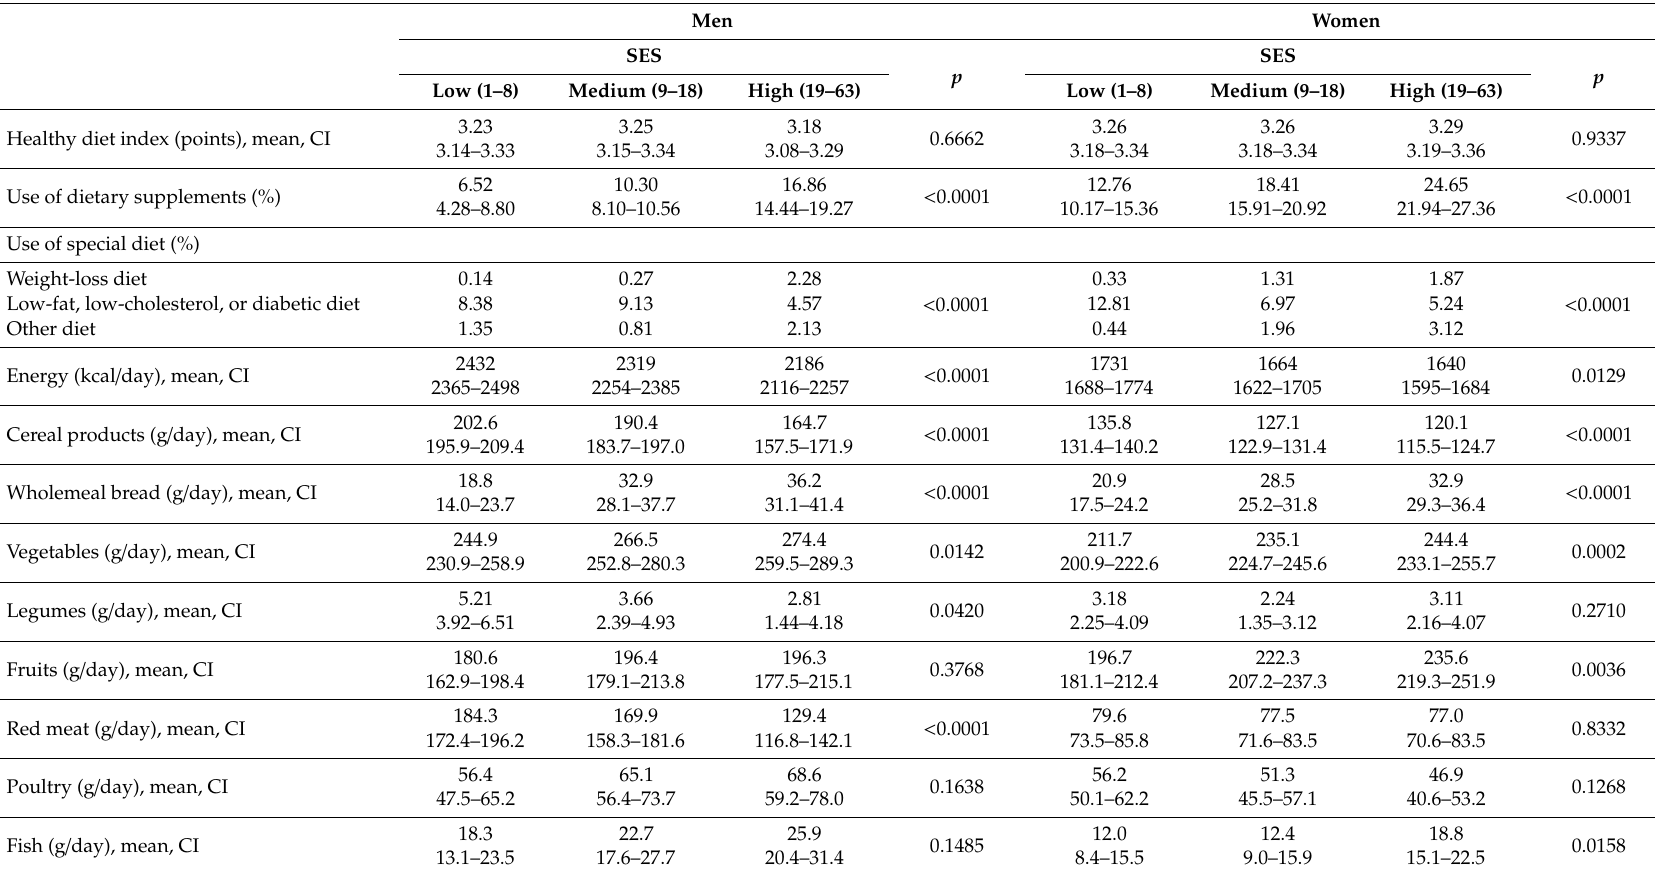
Table 3. Dietary habits of the studied population ( N = 4774) according to their socioeconomic status (SES) score, adjusted for